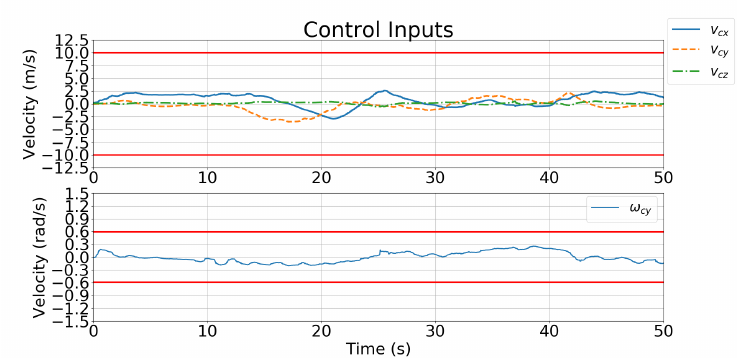
Figure 19. Simulation 2: velocity control input for Case 2.